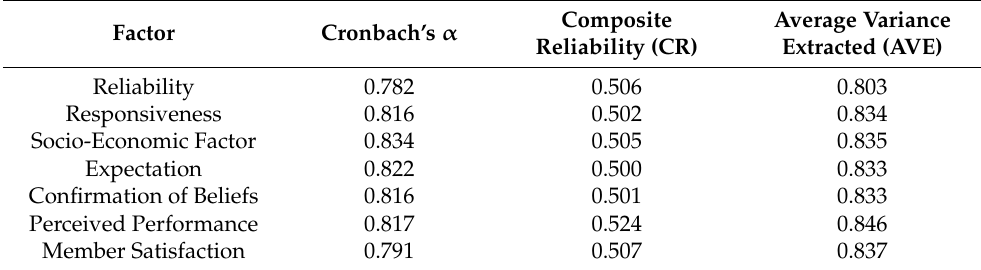
Table 6. Composite Reliability and